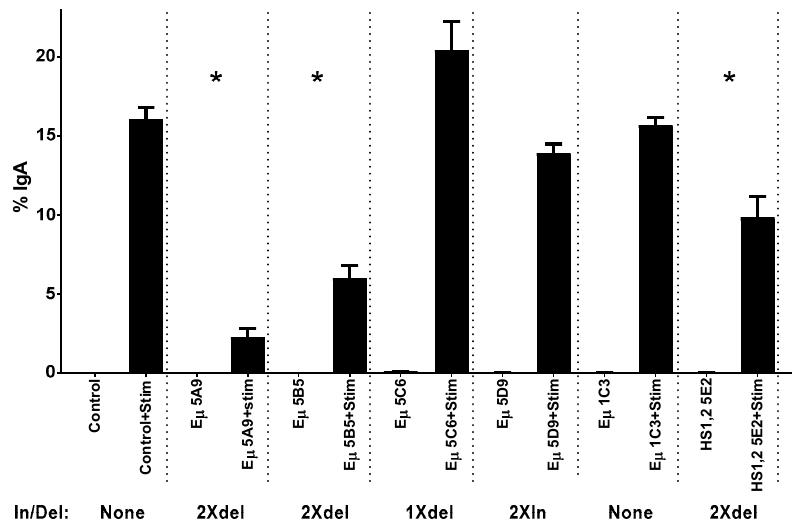
Figure 3. Double deletions of ERE in E µ or HS1,2 significantly reduce CSR to IgA. Cells were stimulated for 3 days using duplicate wells for each variable. Flow cytometry was performed to examine the frequency of cells expressing membrane IgA before and after stimulation. Percentages of live cells bearing membrane IgA are shown, with means and standard deviations. Controls were CH12F3.5B1 and 1C3, a clonal derivative of CH12F3.5B1 with no ERE sequence change. Insertions (In)